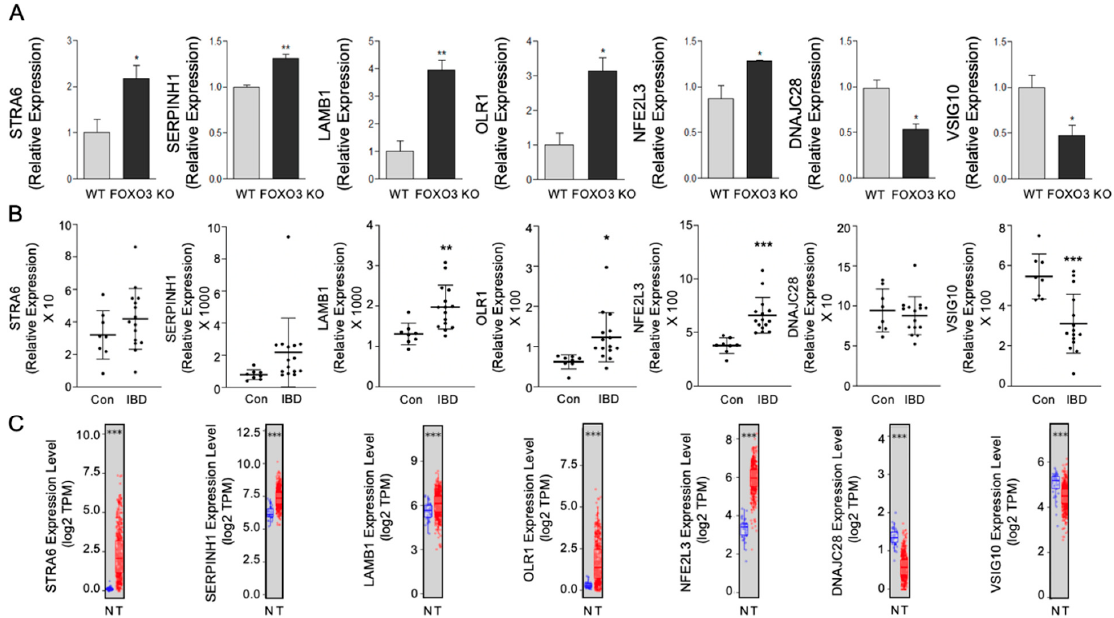
Figure 6. FOXO3-mediated differentially expressed genes in macrophages with unexplored roles in IBD and colon cancer. ( A ) Validation of select FOXO3-dependent STRA6, SERPINH1, LAMB1, OLR1, NFE2L3, DNAJC28 and VSIG10 transcripts in macrophages (qPCR, n = 3, * p < 0.05, ** p < 0.01). ( B , C ) Altered STRA6, SERPINH1, LAMB1, OLR1, NFE2L3, DNAJC28 and VSIG10 levels in human IBD and colon cancer patient transcriptomes ( n = 23, GSE4183; n = 498, TCGA, * p < 0.05, ** p < 0.01, *** p < 0.001).